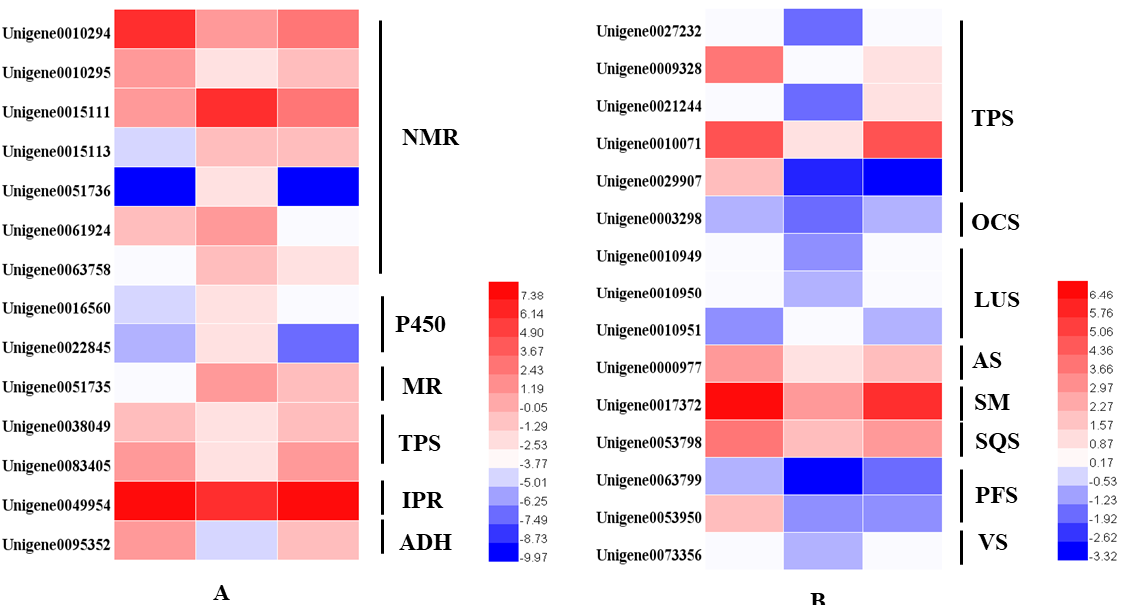
Figure 6. Heatmaps of the DEGs in the monoterpenoid biosynthesis pathway ( A ) and in the sesquiterpenoid and triterpenoid biosynthesis pathways ( B ). NMR, (+)-neomenthol dehydrogenase; P450, cytochrome; MR, ( − )-menthol dehydrogenase; TPS, terpene synthase; IPR, ( − )-isopiperitenone reductase; ADH, alcohol dehydrogenase.